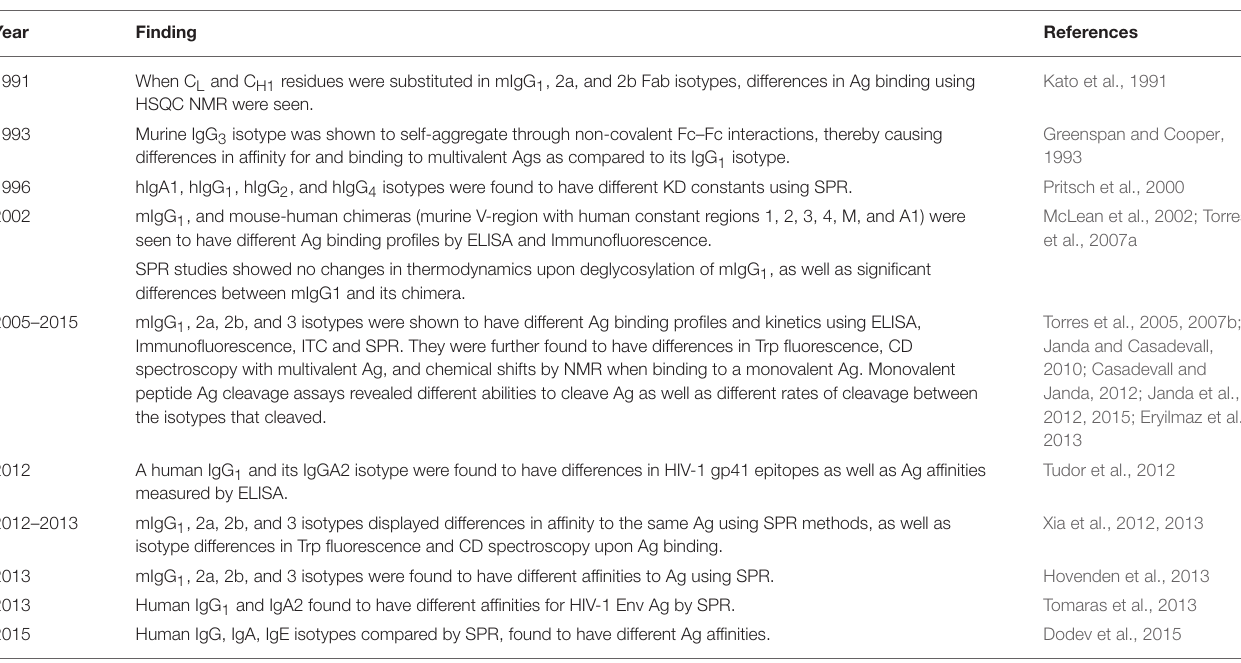
TABLE 1 | Summary of studies finding mAb isotype differences in Ag